Question: Does the figure show an increasing or a decreasing trend?
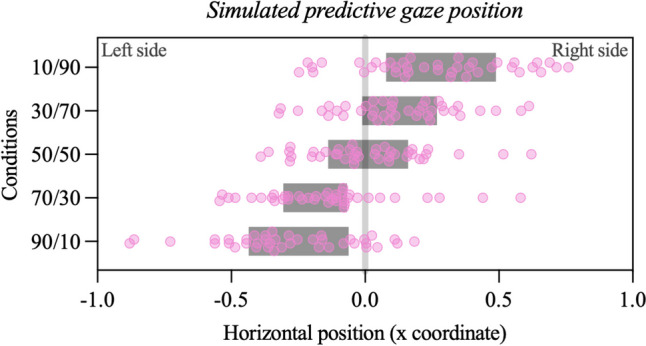
Answer: increasing